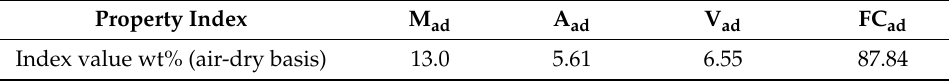
Figure 1. XRD pattern of coal fly ash. Table 2. Industrial analysis of charcoal.